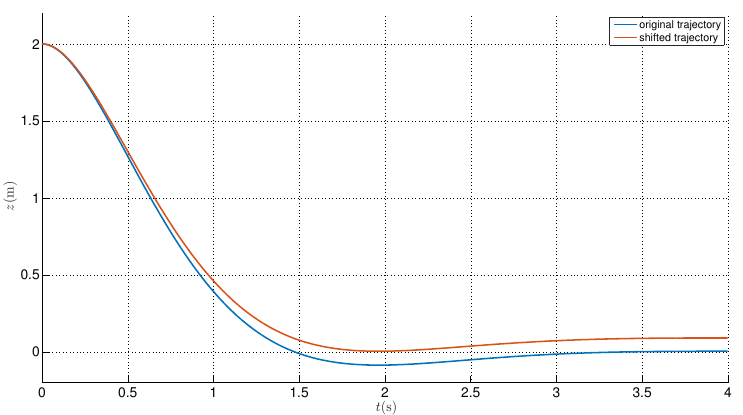
Figure 4. Virtual ground level